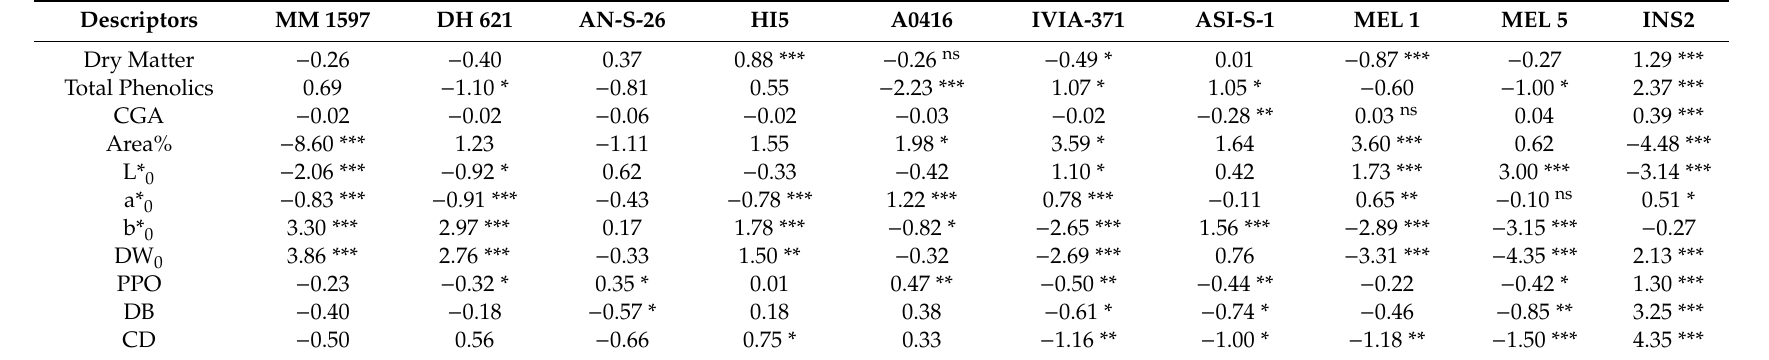
Table 3. General combining ability (GCA) estimates of the parents ( n = 10).